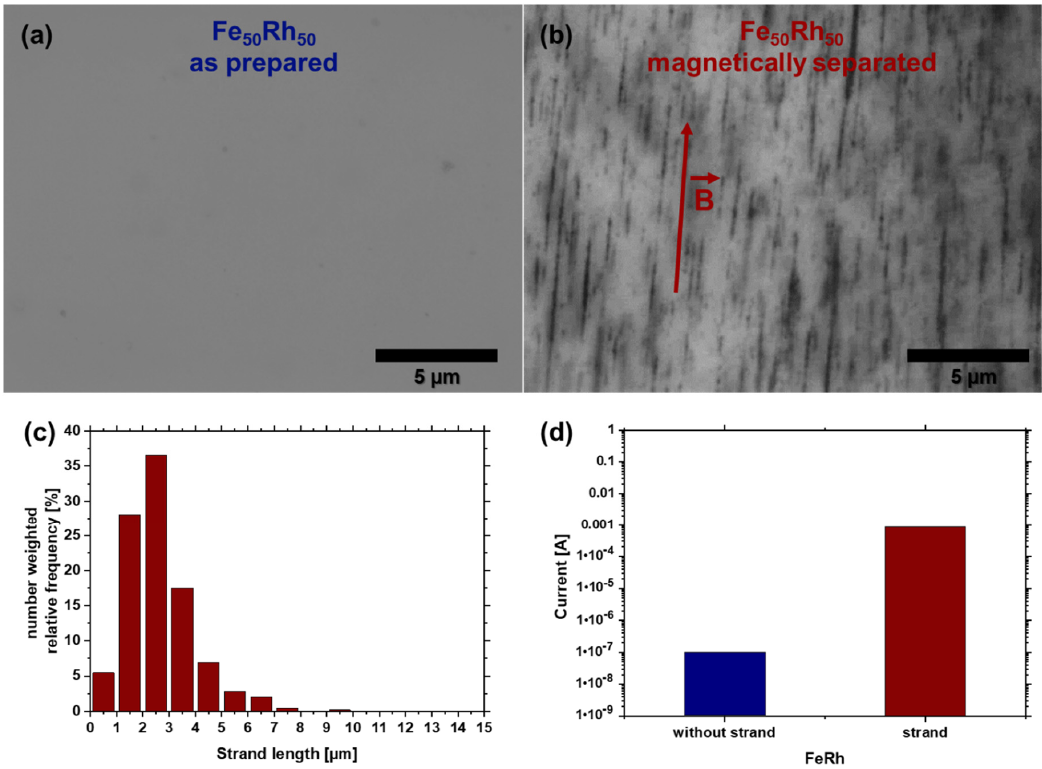
Figure 9. Magnetic-field induced FeRh nanostrand formation in a polymer. Light optical microscopy images of the composite containing Fe 50 Rh 50 nanostrands from ( a ) as-prepared nanoparticles and ( b ) after magnetic separation. The red arrow denotes the direction of the magnetic field. ( c ) Quantification of nanostrand length as extracted from microscopy through image analysis. ( d ) Conductivity measurement of the FeRh particles without and with formed FeRh nanostrands.